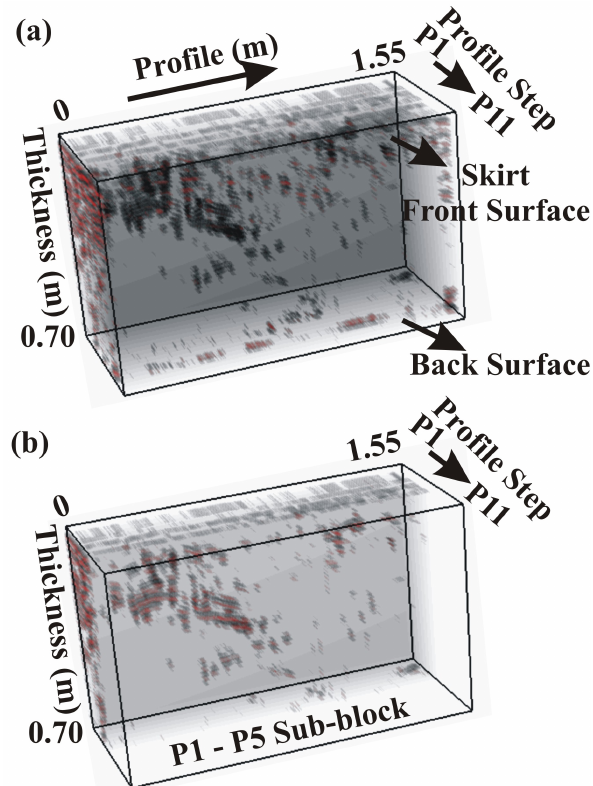
Fig. 11. (a) A transparent 3-D full data block and (b) a transparent 3-D data sub-block between profile 1 and profile 5 of the skirt part of the first woman statue with new opacity function approximation (Fig.